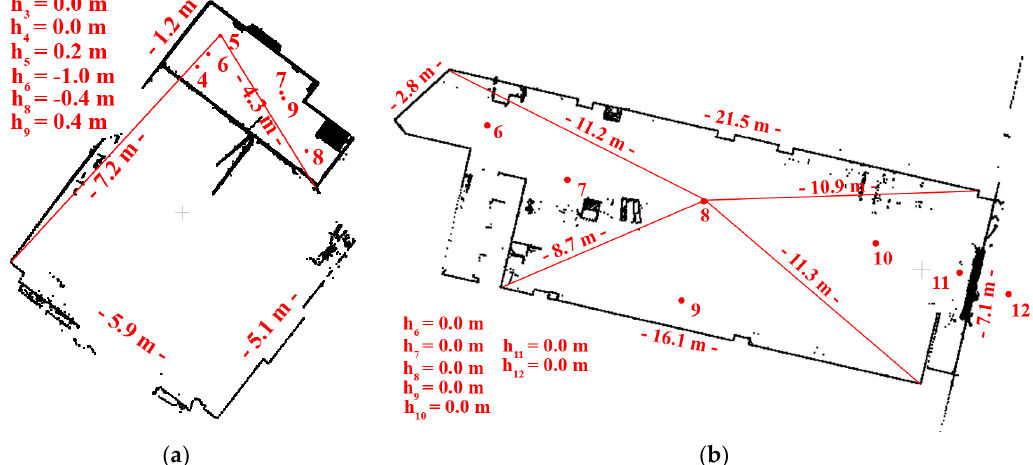
Figure 8. The floodplain with marked TLS scanner position with distances to the nearest walls for: ( a ) test site III: “The office room” and ( b ) test site IV: “Empty shop (shopping mall)”. On figures, the high of each TLS station, related to the reference scan was presented. The h values are related to the high of the reference scan.